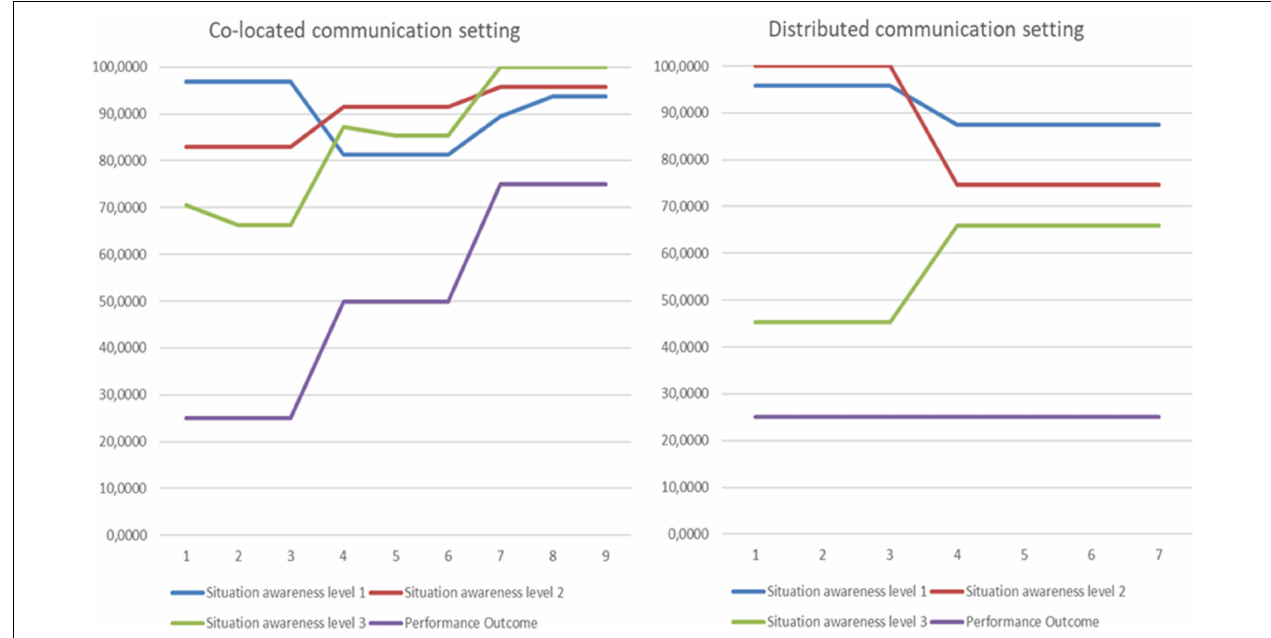
FIGURE 2 | Characteristics of the runs in co-located and distributed